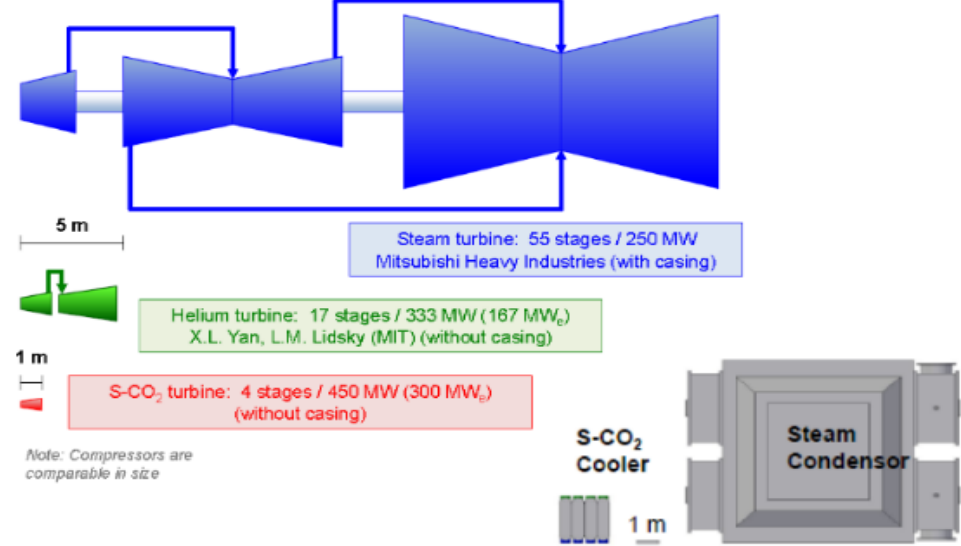
Figure 1. Turbine and Cooler Size comparison for Gas Brayton and steam Rankine cycle.